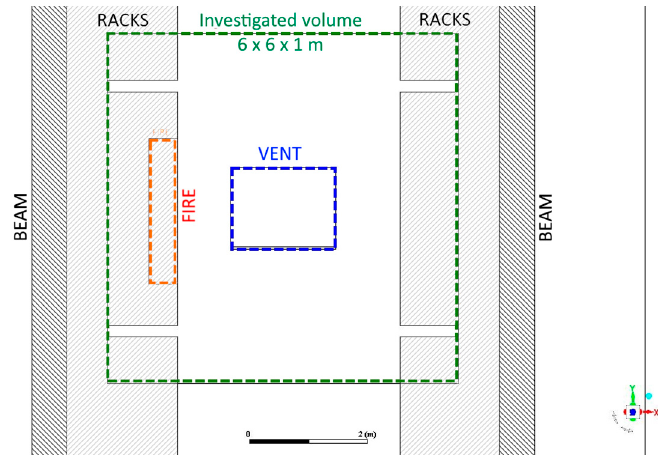
Figure 4. Illustration (top view) of the part of the numerical model used in the post-processing of the results and statistics.